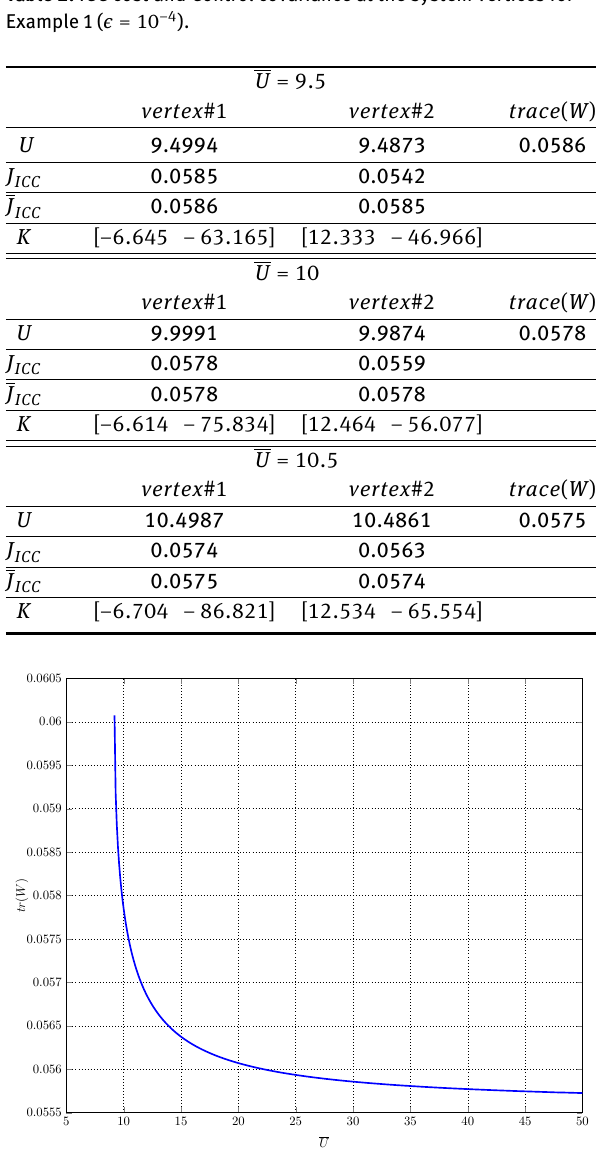
Figure 1: The upper bound on the output performance versus control constraints.